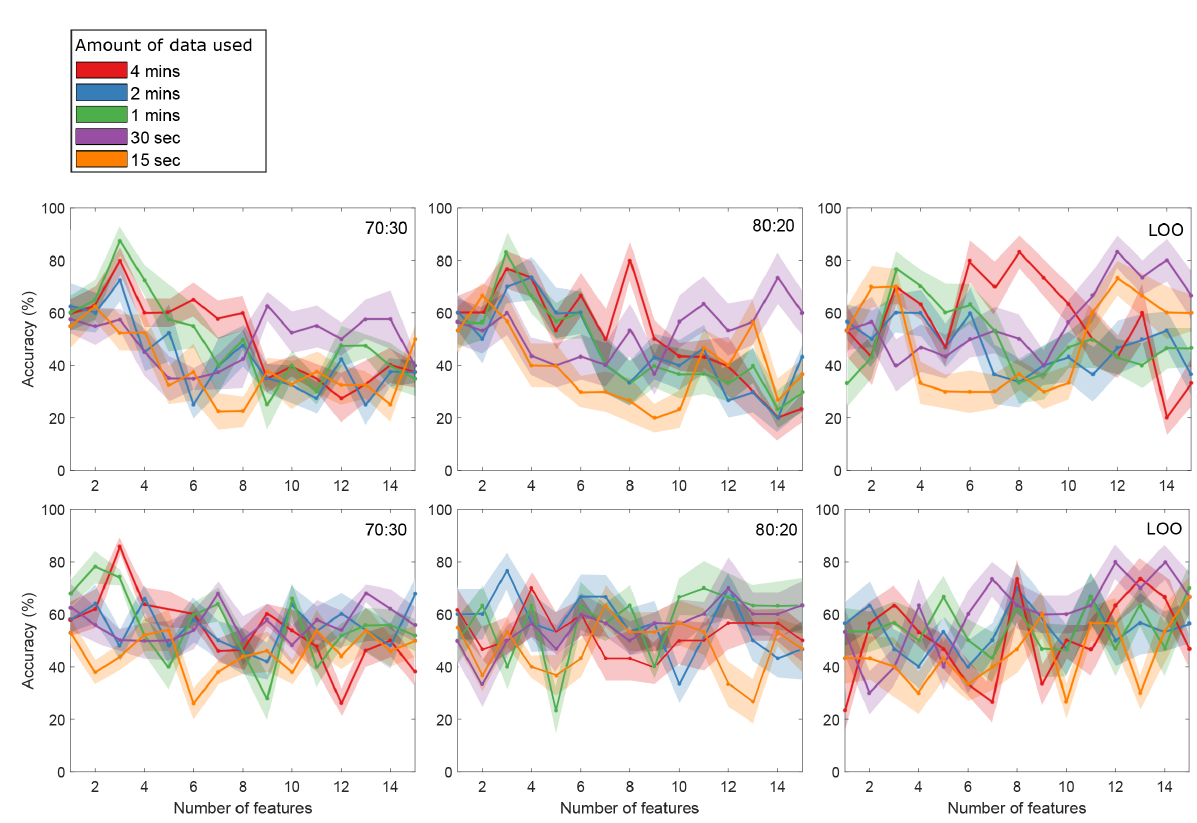
Figure 6. Average classification accuracies for the EEG ( top row) and NR-EEG models ( bottom row) ( K = 15 features), using 4 min, 2 min, 1 min, 30 s and 15 s of data during the AO task. Shaded area represents standard error across cross-validations. Model performance was evaluated using 70:30 ( left ), 80:20 ( middle ) and LOO ( right ) data splitting approaches.